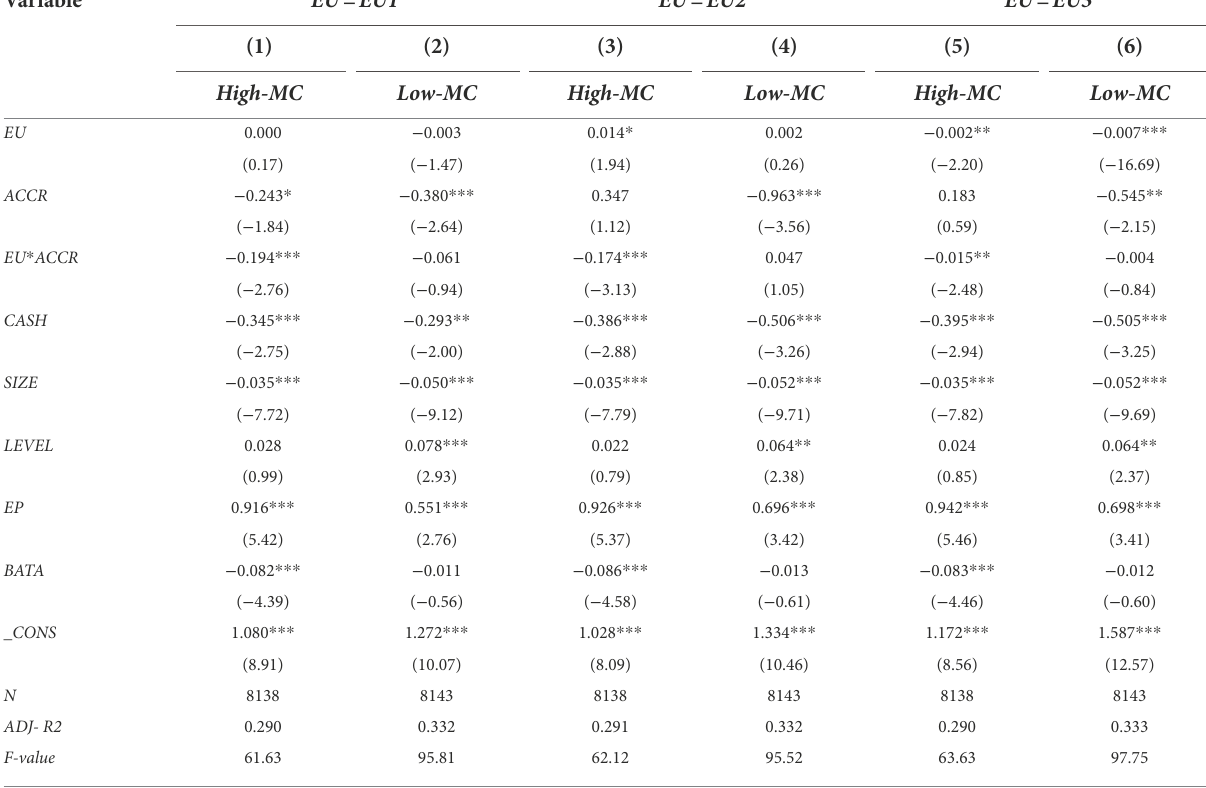
TABLE 7 The relation between environmental uncertainty and accrual anomaly in Group 3.